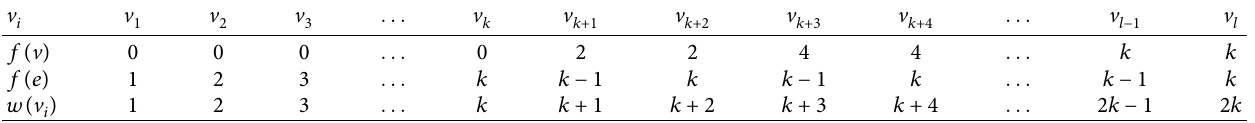
Table 1: Labeling of vertex and edge on pendant